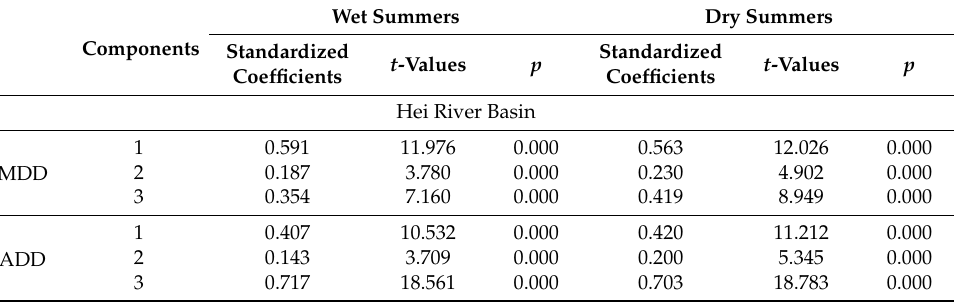
Table 6. Standardized coefficients of linear regression equations on the relationships of summer runoff indices with extracted components from precipitation and temperature indices during wet and dry summers. The significances of these coefficients are tested by t -test and the results are illustrated by t statistic values and their associated significance probability: p -values. If p < 0.05, the coefficients are significant at the 95% confidence